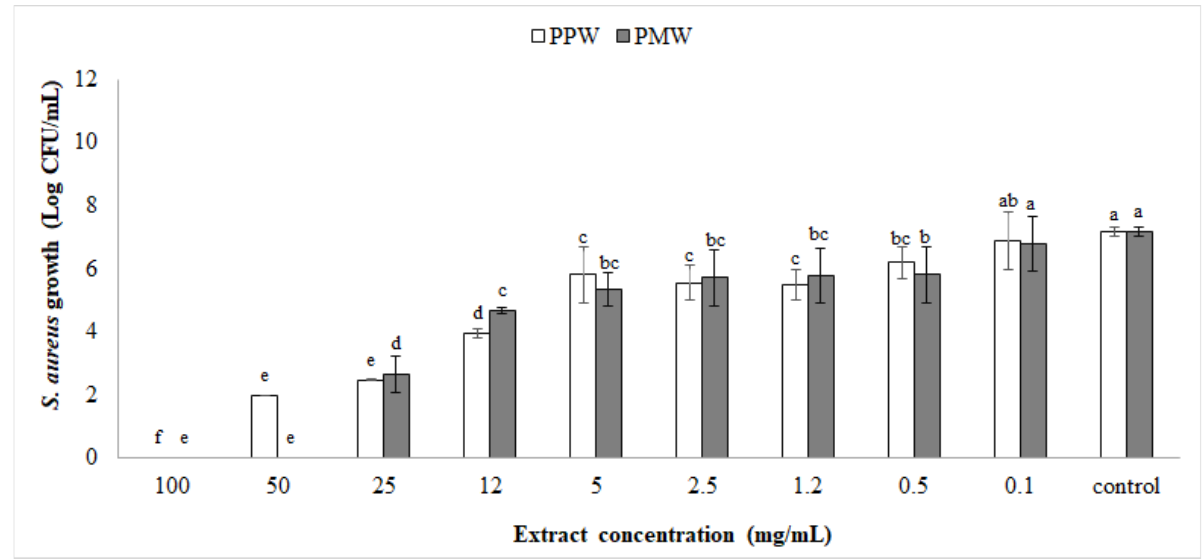
Figure 1. In vitro antimicrobial activity of pomegranate extracts from peel (PPW) or mesocarp (PMW) against S. aureus . Vertical bars indicate the standard deviation of the mean. Values in columns marked by a different letter are significantly different according to Fisher’s least significant difference test ( p < 0.05).